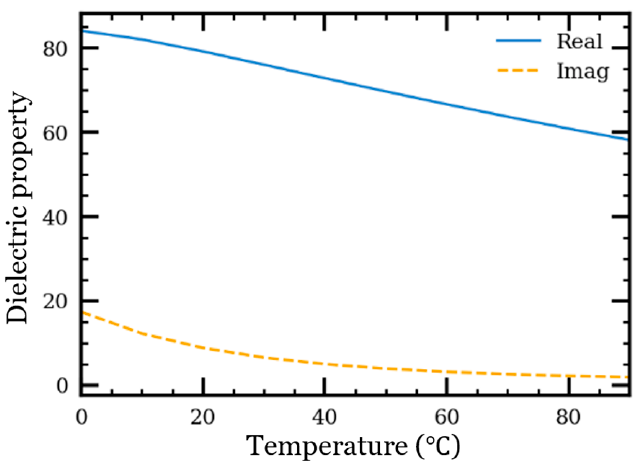
Figure 6. Dielectric property of water changing with temperature in 2 GHz.